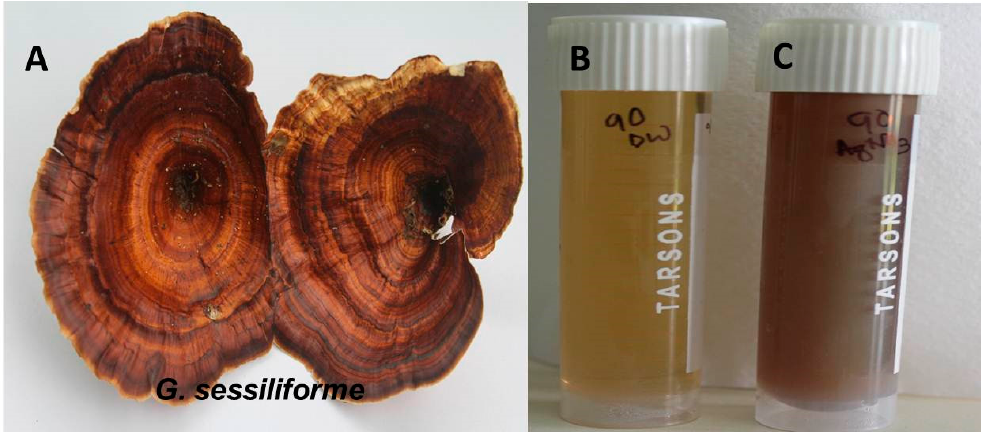
Figure 1. ( A ) G. sessiliforme; ( B ) G. sessiliforme mycelial extract and AgNO 3 ; ( C ) synthesized silver nanoparticles (AgNPs). nanoparticles